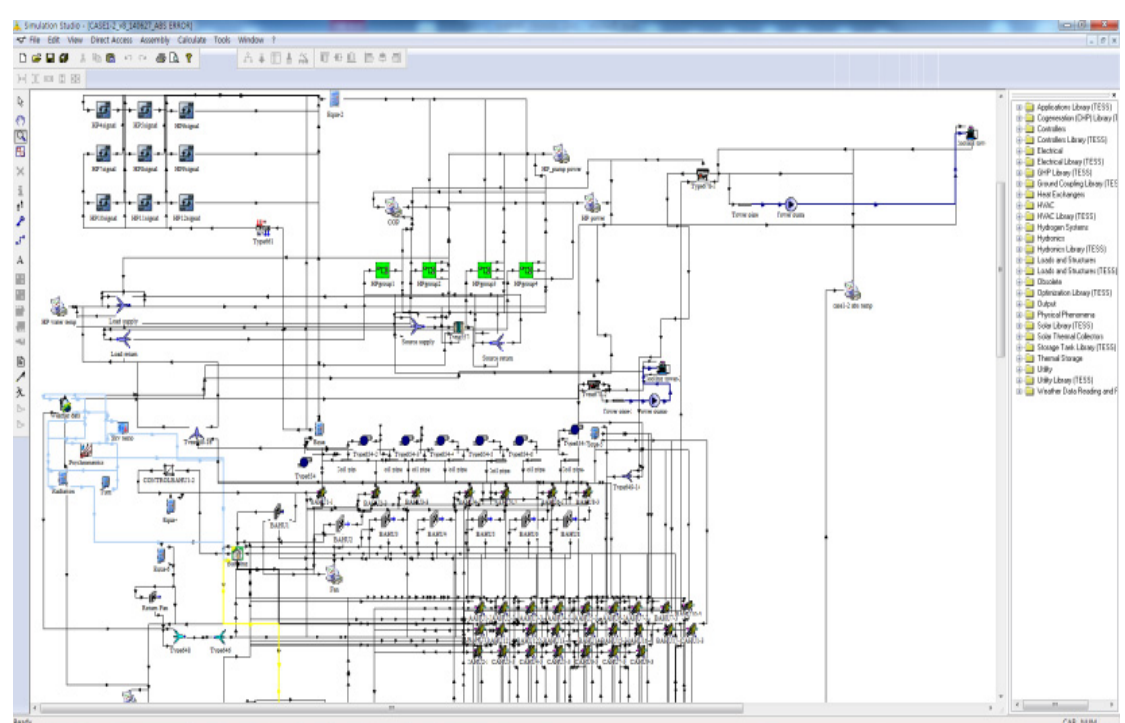
Figure 10. Transient system simulation program (TRNSYS) simulation studio